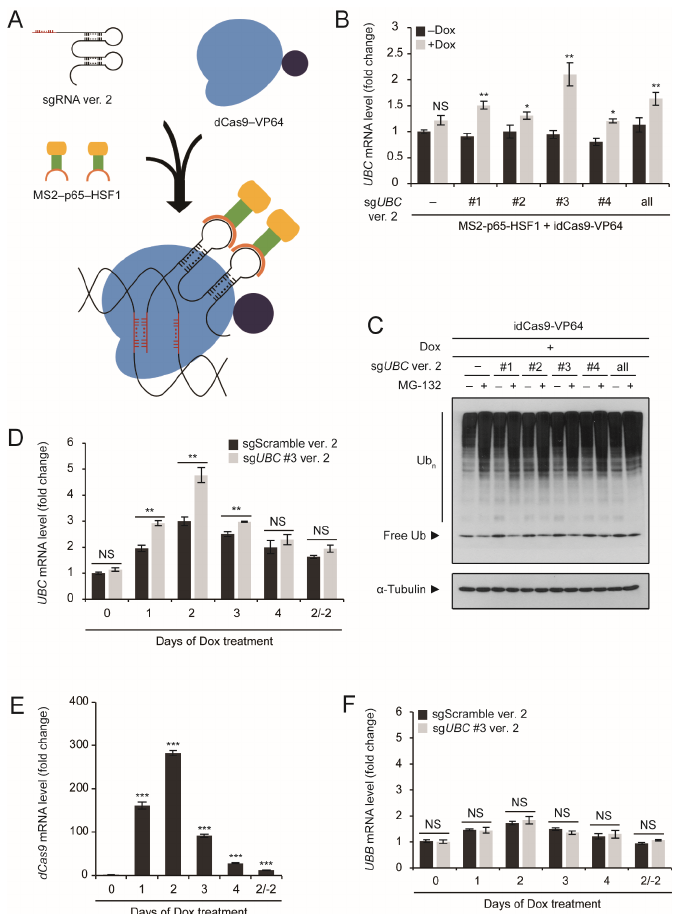
Figure 3. Application of an MS2 RNA aptamer and additional activators for UBC upregulation, based on the idCas9–VP64 system. ( A ) Schematic diagram of the working model of the MS2 aptamer and additional activators for the CRISPR activation system. MS2 protein conjugated to C-terminal activator domains, composed of the mouse NF-κB subunit (p65) and human heat shock factor 1 (HSF1), binds to the MS2 RNA stem-loop structure of sgRNA ver. 2. These sgRNA ver. 2 and MS2-p65-HSF1 complexes cooperate with idCas9–VP64 for the upregulation of target genes. ( B ) HEK293T cells were transiently transfected with idCas9–VP64, MS2-p65-HSF1, and scrambled sgRNA ver. 2 (indicated as -) or sg UBC #1~#4 ver. 2 (alone or in combination), and then treated with 10 µ g / mL Dox for 2 days. UBC mRNA levels were determined by qRT-PCR ( n = 3 each), normalized to GAPDH , and expressed as the fold change relative to the control (-Dox, scrambled sgRNA ver. 2). ( C ) Transient transfection of HEK293T cells and Dox treatment were performed as described in ( B ). Ub conjugates (Ub n ) and free Ub were detected by immunoblot analysis using an anti-Ub antibody. α -Tubulin was used as a loading control. ( D , F ) HEK293T cells were transiently transfected with idCas9–VP64, MS2-p65-HSF1, and scrambled sgRNA (sgScramble) ver. 2 or sg UBC #3 ver. 2, and then treated with 10 µ g / mL Dox for up to 4 days. To washout Dox, cells were treated with 10 µ g / mL Dox for 2 days and it was then removed from the media for 2 days (2 / -2). UBC and UBB mRNA levels were determined by qRT-PCR ( n = 3 each), normalized to GAPDH , and expressed as the fold change relative to the control (0 days of Dox treatment, scrambled sgRNA ver. 2). ( E ) HEK293T cells were transiently transfected with idCas9–VP64, MS2-p65-HSF1, and sg UBC #3 ver. 2, and then treated with 10 µ g / mL Dox for up to 4 days. Dox washout (2 / -2) was performed as described above. dCas9 mRNA levels were determined by qRT-PCR ( n = 3 each), normalized to GAPDH , and expressed as the fold change relative to the control (0 days of Dox treatment, scrambled sgRNA ver. 2). Representative immunoblots are shown from three independent experiments ( C ). All data are presented as means ± SEM from the indicated number of samples. * p < 0.05; ** p < 0.01; *** p < 0.001 vs. control (0 days of Dox treatment or -Dox) or between two groups as indicated by horizontal bars. NS: Not